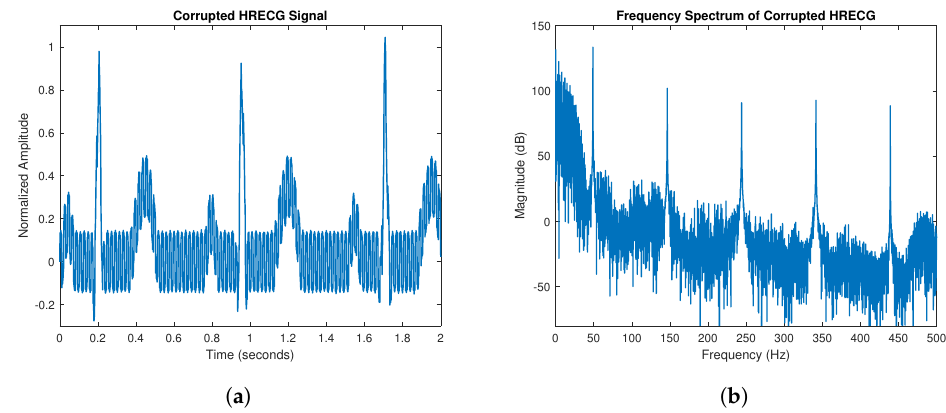
Figure 5. The PLI-corrupted cardiac signal plus its frequency spectrum. ( a ) PLI-corrupted HRECG signal; ( b ) the frequency response with the 1st, 3rd, 5th, 7th, and 9th harmonics of